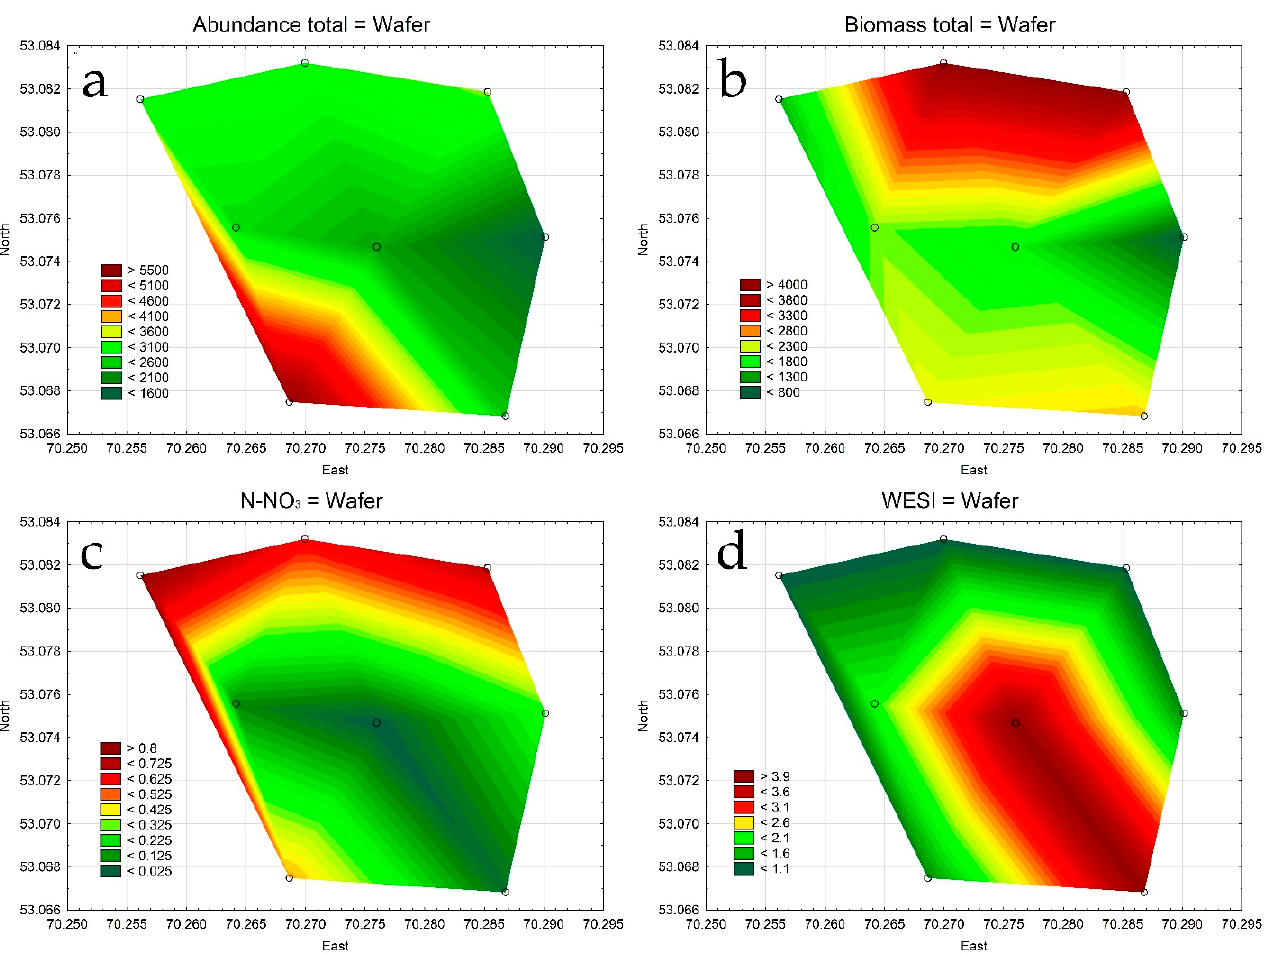
Figure 6. Maps of the surface phytoplankton abundance ( a ), biomass ( b ), nitrates ( c ), and WESI index ( d ) in Lake Borovoe, summer 2019.